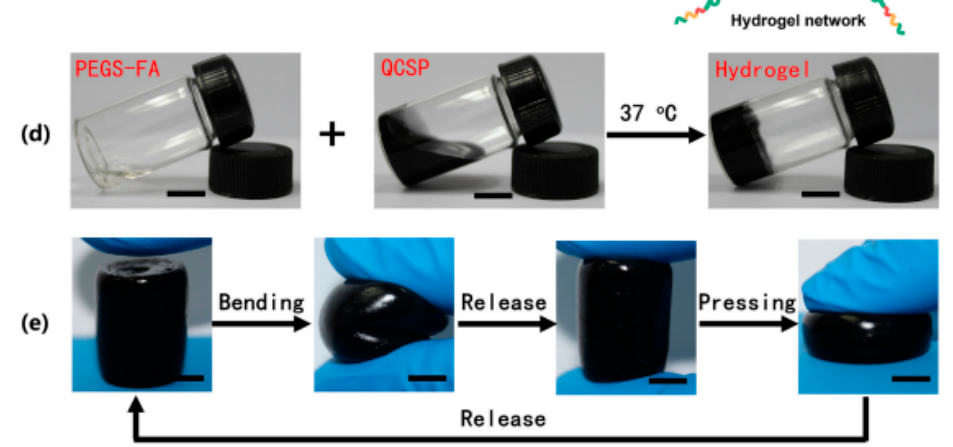
Figure 3. Scheme showing the synthesis of chitosan- g -aniline ( a ), PEGS-FA copolymers ( b ) and the structure of the hydrogel derived from both copolymers ( c ). Photographs showing the corresponding solutions ( d ) and flexible behavior of the hydrogel under bending and pressing efforts ( e ). Reproduced with permission from [89], copyright 2017